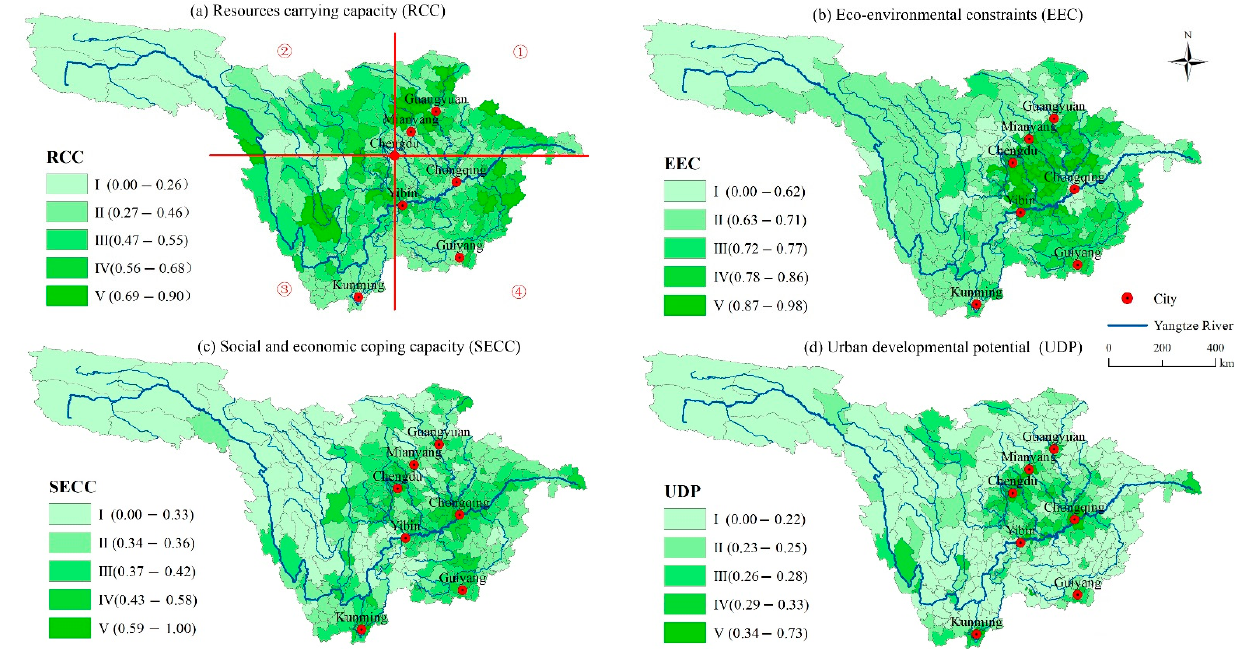
Figure 3. Suitability of urban construction land (SUCL) at different dimensions.